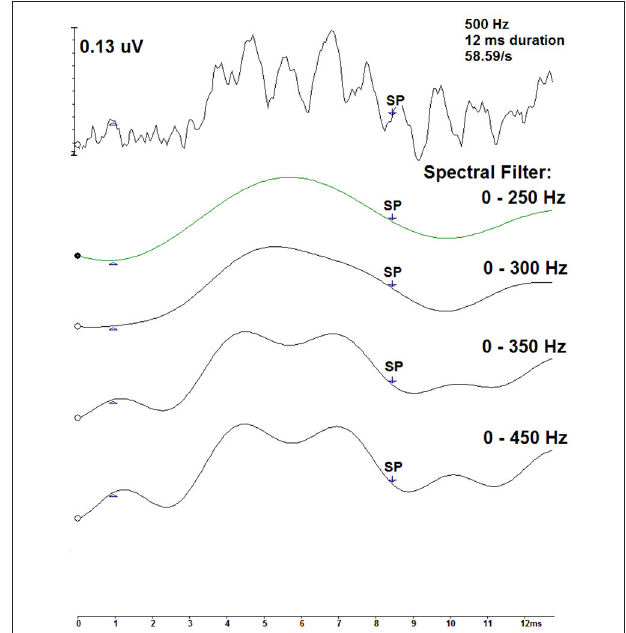
FIGURE 7 | Spectral filtering of a CLAD deconvolved tone burst ECochG waveform (top) for the 500 Hz, 12 ms, 58.59/s condition. Displayed in descending order, four spectral band pass filters were applied: 0–250, 0–300, 0–350, and 0–450 Hz. SP indicates the pre-defined midpoint of the 12 ms